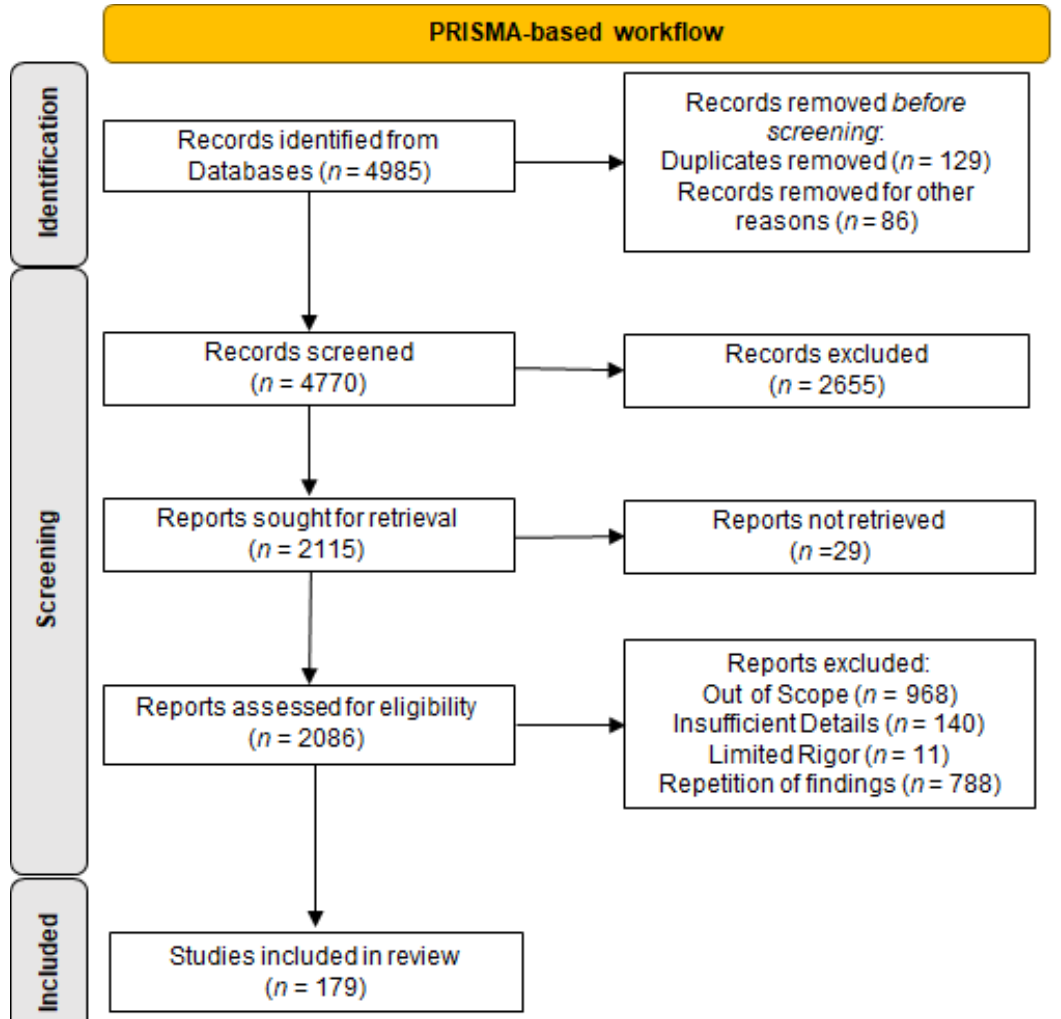
Figure 2. PRISMA-based scheme describing the search strategy.